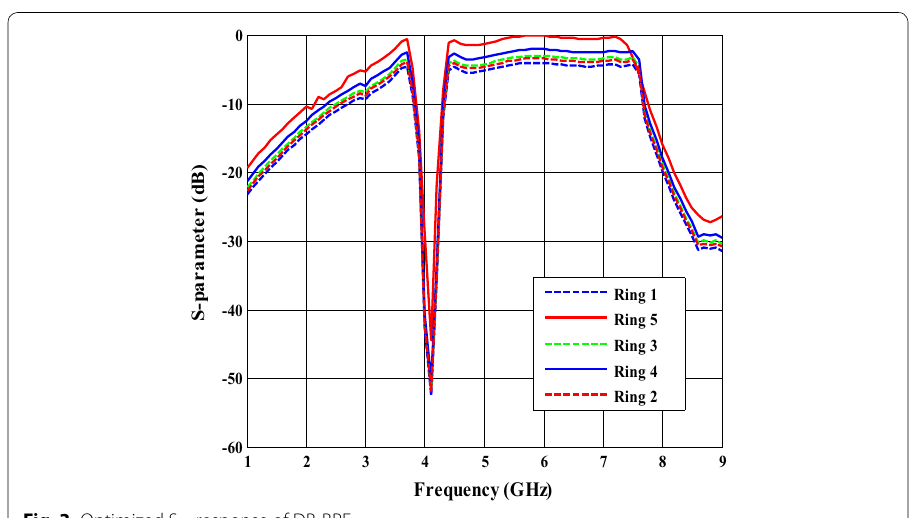
Fig. 3 Optimized S 21 response of